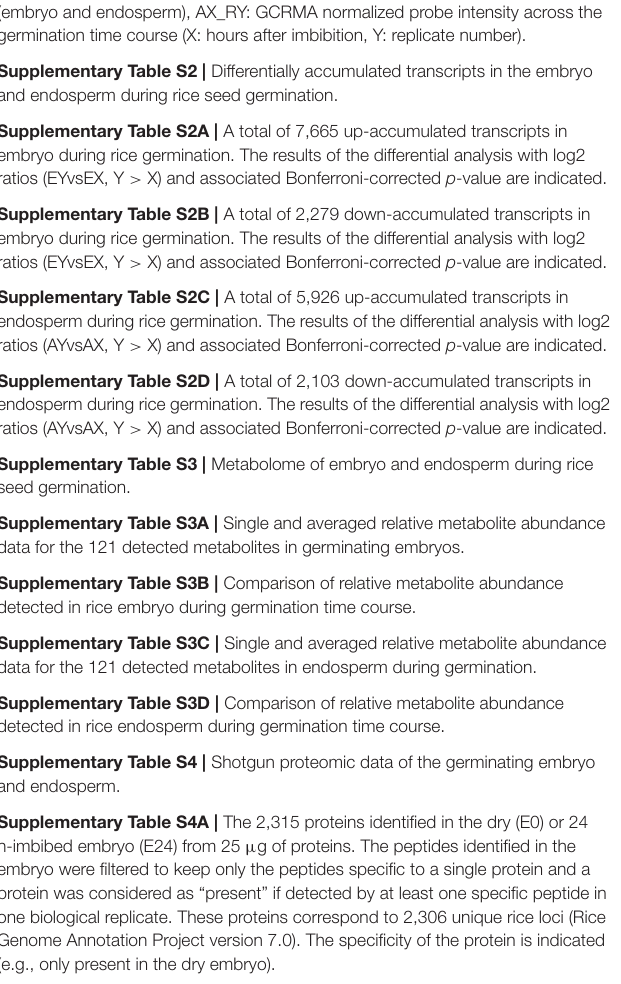
Supplementary Table S1B | Endosperm germination transcriptome data. According to the MAS5 algorithm, we detected 24,695 Affymetrix probes called “present” in at least one imbibition time and in at least two replicates (out of three) during embryo germination. Affymetrix control probes and locus non-specific